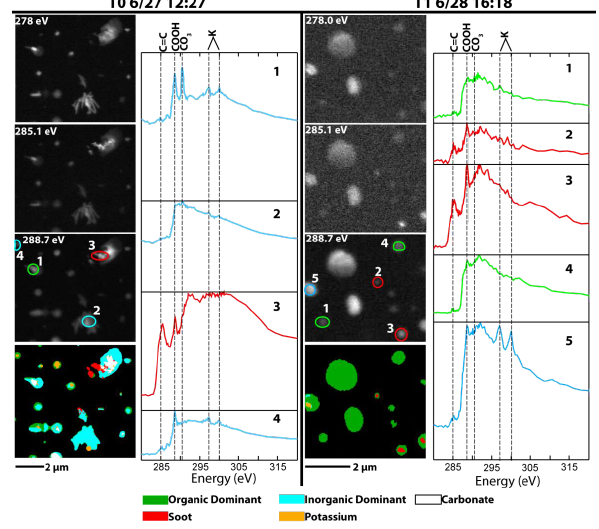
Figure 4. Samples selected from a period of low (T0, 6/27 12:27) and high (T1, 6/28 16:18) 2 Fig. 4. Samples selected from a period of low (T0, 27 June, 12:27) organic mass loading displayed significant differences in mixing state. Single energy 3 and high (T1, 28 June, 16:18) organic mass loading displayed sig- STXM/NEXAFS images and spectra show spatial distributions of major components 4 nificant differences in mixing state. Single energy STXM/NEXAFS identified at the carbon K-edge. Particles or regions where the spectra are obtained are 5 images and spectra show spatial distributions of major components indicated by numbers. 6 identified at the carbon K-edge. Particles or regions where the spec- tra are obtained are indicated by